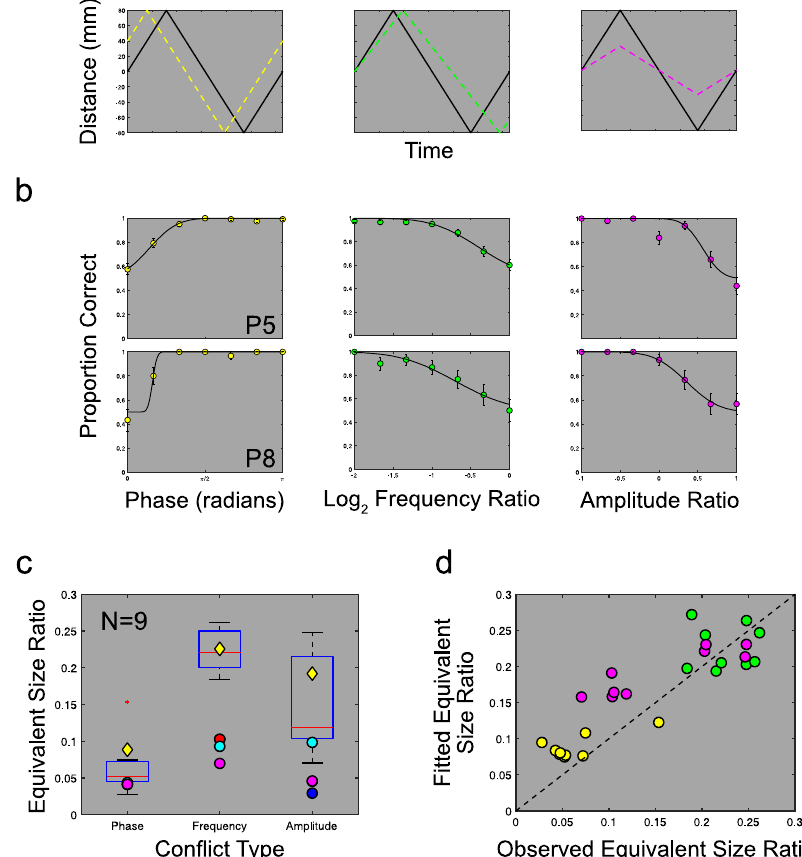
Figure 3. Co-occurrence statistics explain human cue conflict discrimination. ( a ) Illustration of the three conflict types applied in Experiment 2. Colour coding for phase (yellow), frequency (green) and amplitude (magenta) conflicts are preserved in b and d. Dashed coloured lines show CS, black lines show CD. ( b ) Psychometric functions for two example participants for each conflict type. ( c ) To compare conflict types, we found the equivalent physical size change that would have produced the observed threshold-level cue conflict. This was summarised as the ratio of CD to CS surface sizes, taking the absolute maximum on a log 2 scale. Boxplots show the mean and range of equivalent size ratios found across participants. Yellow diamonds show the results of this analysis for the cue co-occurrence model, which provided a good fit to human observers. Results are also shown for joint distribution model variants that measured the standard deviation and maximum differences (blue; red), or ratios (cyan; magenta), in estimated speed-in-depth between cues (variants based on physical size estimates performed at chance level and are therefore not plotted). ( d ) Equivalent size ratios for each conflict type, for each participant, plotted against fits for the cue co-occurrence